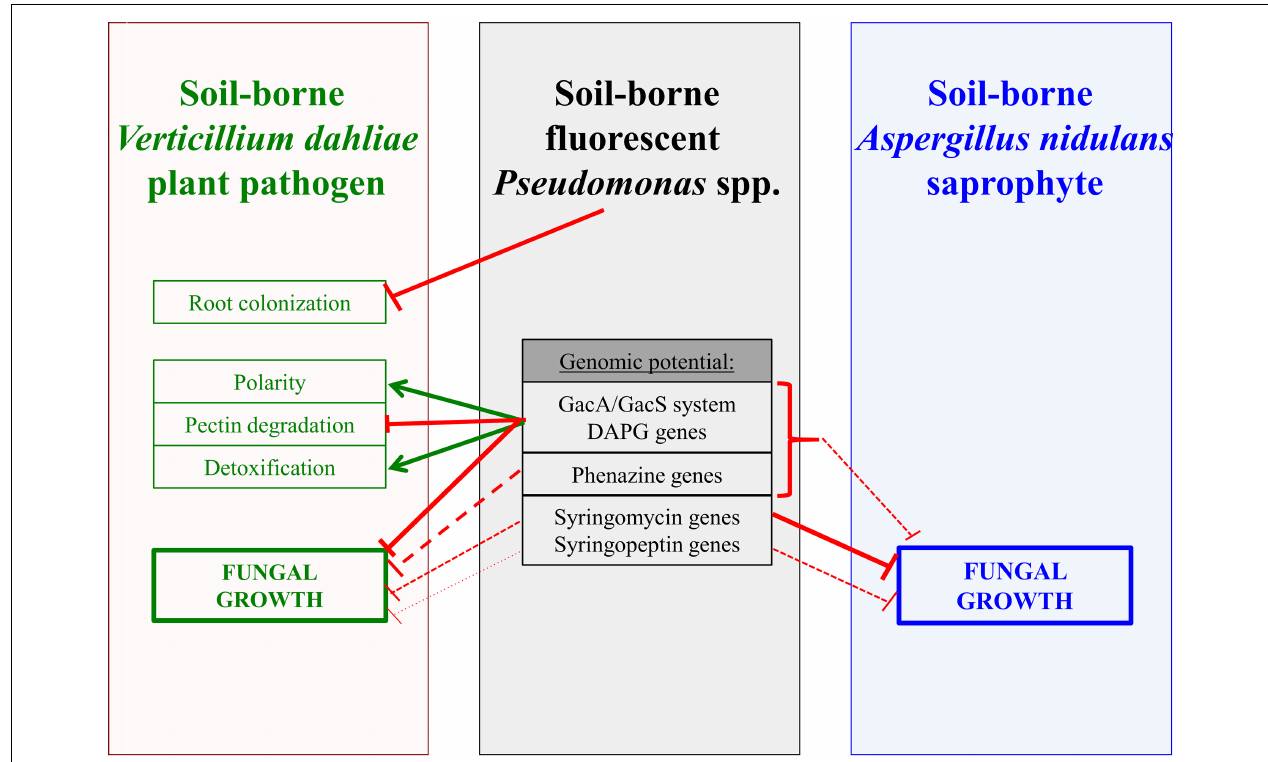
FIGURE 4 | Interplay of Pseudomona s strains with fungal phytopathogen Verticillium dahliae or saprophyte Aspergillus nidulans . Fluorescent pseudomonads isolated from different rhizospheres or groundwater affect Verticillium dahliae and its amphidiploid hybrid V. longisporum as well as growth of A. nidulans . Inhibitory and promoting activities of the bacteria are indicated by red connectors and green arrows, respectively. Dashed lines and smaller line width indicate weaker effects. The bacterial GacS/GacA two component system controls the formation of several bacterial metabolites. For details see text. DAPG: 2,4-diacetylphloroglucinol